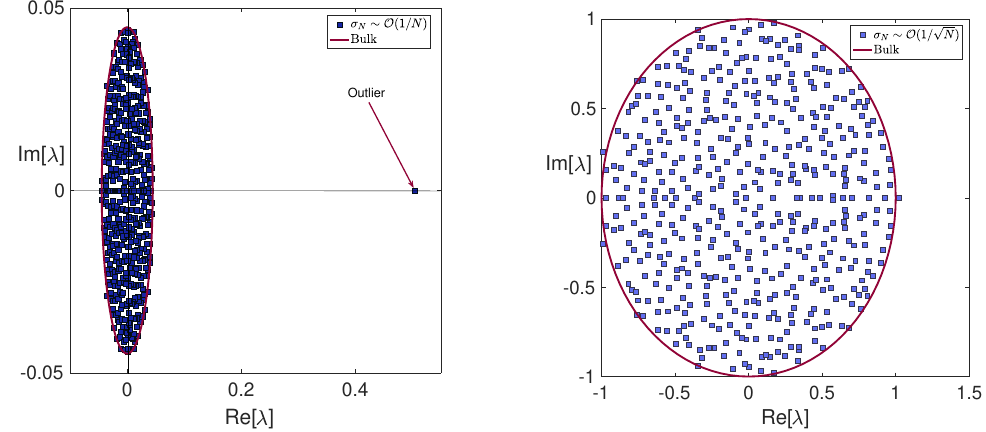
= ¯ z is clearly out = ¯ z out